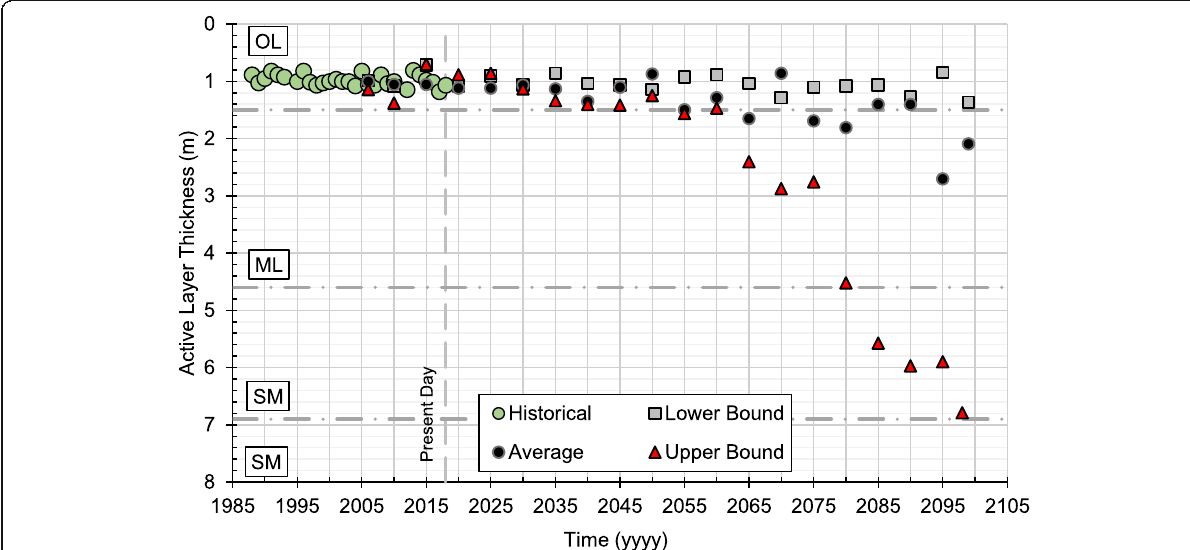
Fig. 10 Modeled ALT from 1988 to 2100 for undisturbed tundra. Scenarios 1, 2, and 3 are represented by Average, Upper Bound, and Lower Bound in the figure,